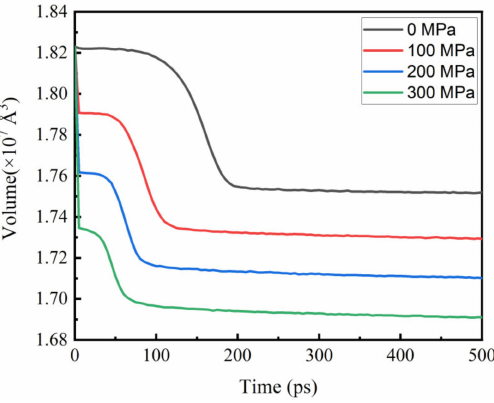
Figure 6. Volume of atoms-vs.-time curves under different